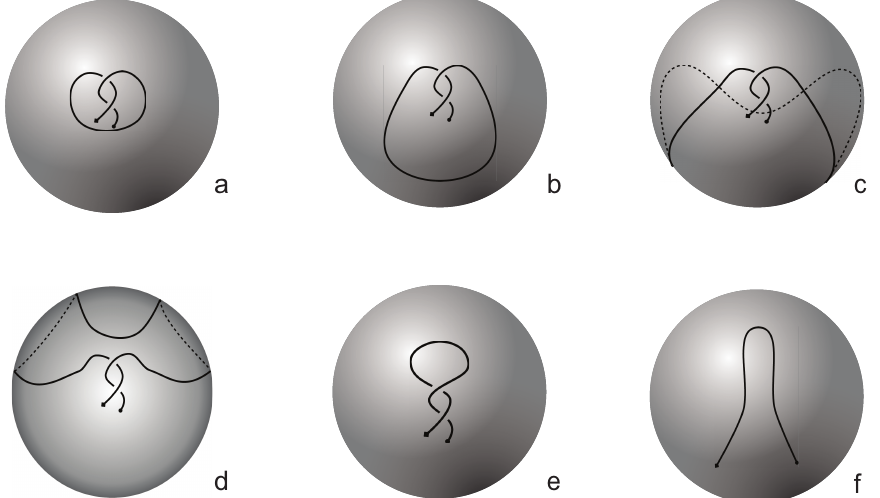
Figure 3. The planar knotoid k 2.3 p is trivial when considered in S 2 . We start by placing k 2.3 p in S 2 ( a ). Then, the lower arc is stretched ( b ) and pulled towards and past the south pole, around the back ( c ) and finally is brought up again ( d ). The application of two Reidemeister I moves completes the proof ( e,f ). The dotted lines indicate parts of the diagram that are on the back side of the